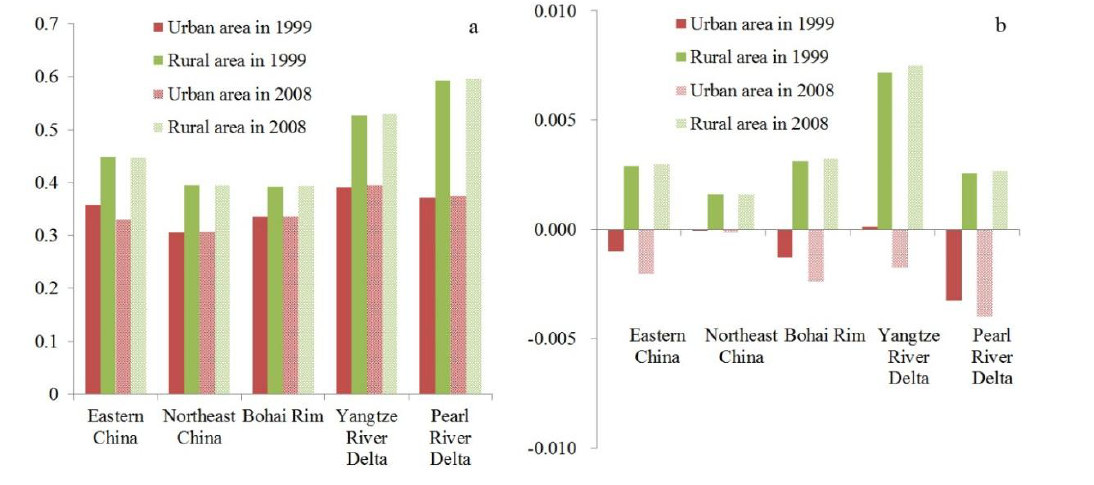
Figure 8. NDVI change of the urban and rural areas in Eastern China in 1999 and 2008. ( a ) Mean NDVI; and ( b ) slope of NDVI change